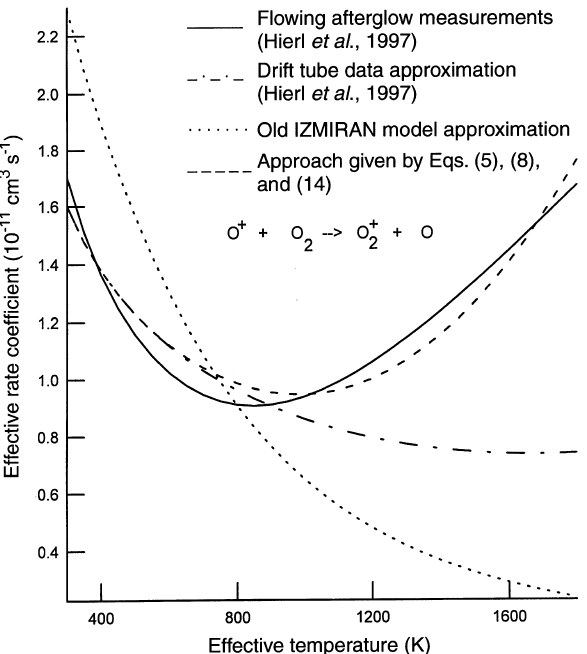
Fig. 2. E(cid:128)ective rate coe(cid:129)cients for the reaction of O (cid:135) (cid:133) 4 S (cid:134) with O 2 as a function of a temperature from a high-temperature flowing afterglow (Hierl et al. , 1997) ( solid line ), drift tube data of Albritton et al. (1977) scaled by a factor of 0.8 (Hierl et al. , 1997) ( dashed-dotted line ), the old IZMIRAN model approximation given by Pavlov (1997) ( dotted line ), and Eqs. (5), (8), and (14) ( dashed